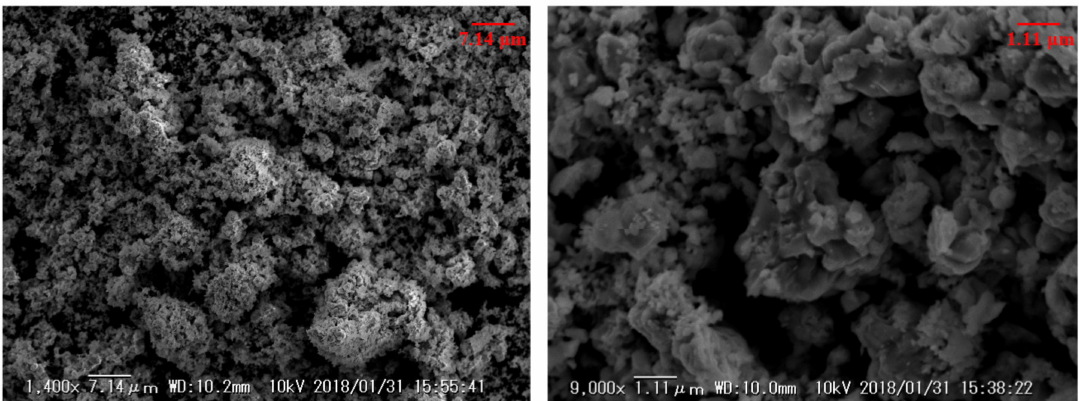
Figure 5. SEM images of NiFe catalyst particles at 1400 × and 9000 ×